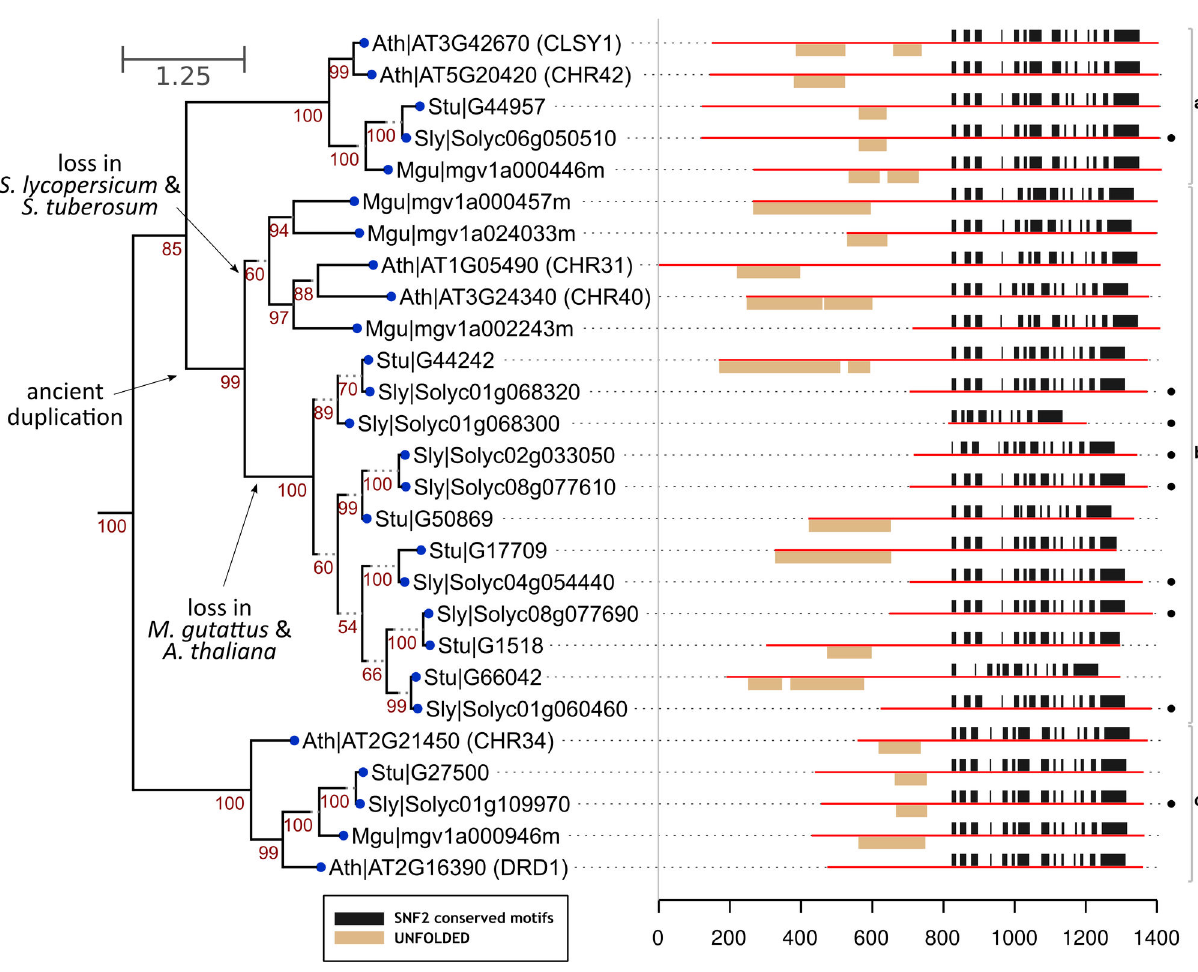
Figure 3. Analysis of the DRD1 subfamily in tomato, potato, Mimulus and Arabidopsis. The left side shows a detailed view of the DRD1 subfamily branch of an unrooted tree based on 1000 bootstraps of Snf2 data from Arabidopsis thaliana (Ath), Mimulus guttatus (Mgu), Solanum lycopersicum (Sly) and Solanum tuberosum (Stu). Confidence values (50-100) are given at the relevant branches of the tree. Identifiers give the name of the organism in three-letter abbreviations together with gene identifiers. The individual branches identified are indicated by letters in lowercase on the right side. To increase readability, some branch edges have been extended by dotted grey lines. These grey dotted lines are therefore not part of the estimated branch length. The right side shows structural elements (domains and unfolded regions) in the protein sequence of the DRD1 subfamily members in Arabidopsis, Mimulus, tomato and potato. Besides the ATPase region no other domains are present in these genes. A black dot at the right end of the figure indicates the expression of the respective gene in tomato based on the analysis of RNA-seq data. doi: